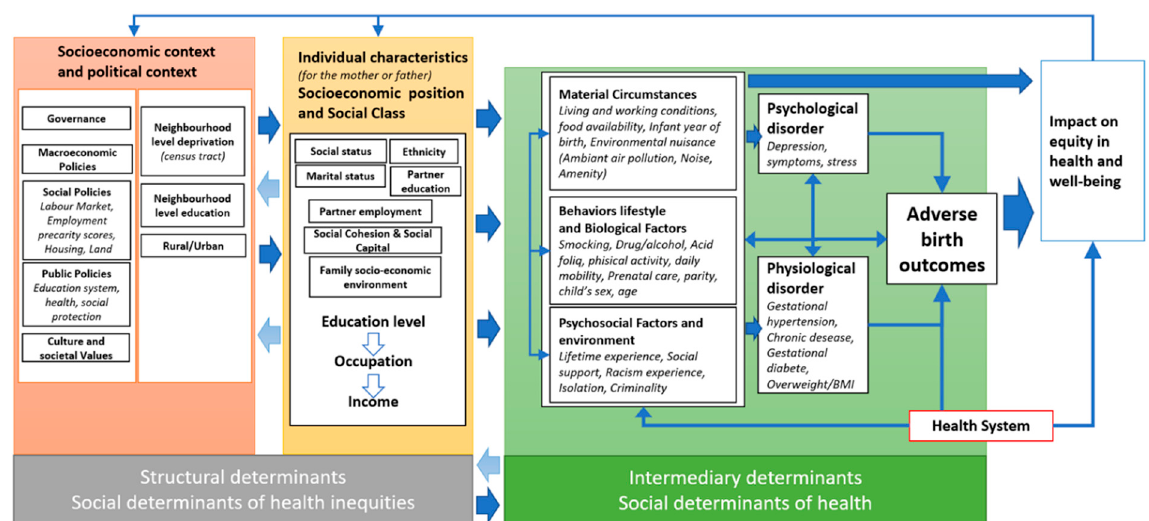
Figure 1. A conceptual framework adapted and modified from the WHO’s Commission of Social Determinants of Health and from the analysis of the studies reviewed. Amenity is a useful or enjoyable feature. An environmental amenity is referred to any benefits that increase the attractiveness of a place or neighborhood by increasing its comfort or convenience. Examples of amenities are pleasant views, good schools or good green space.